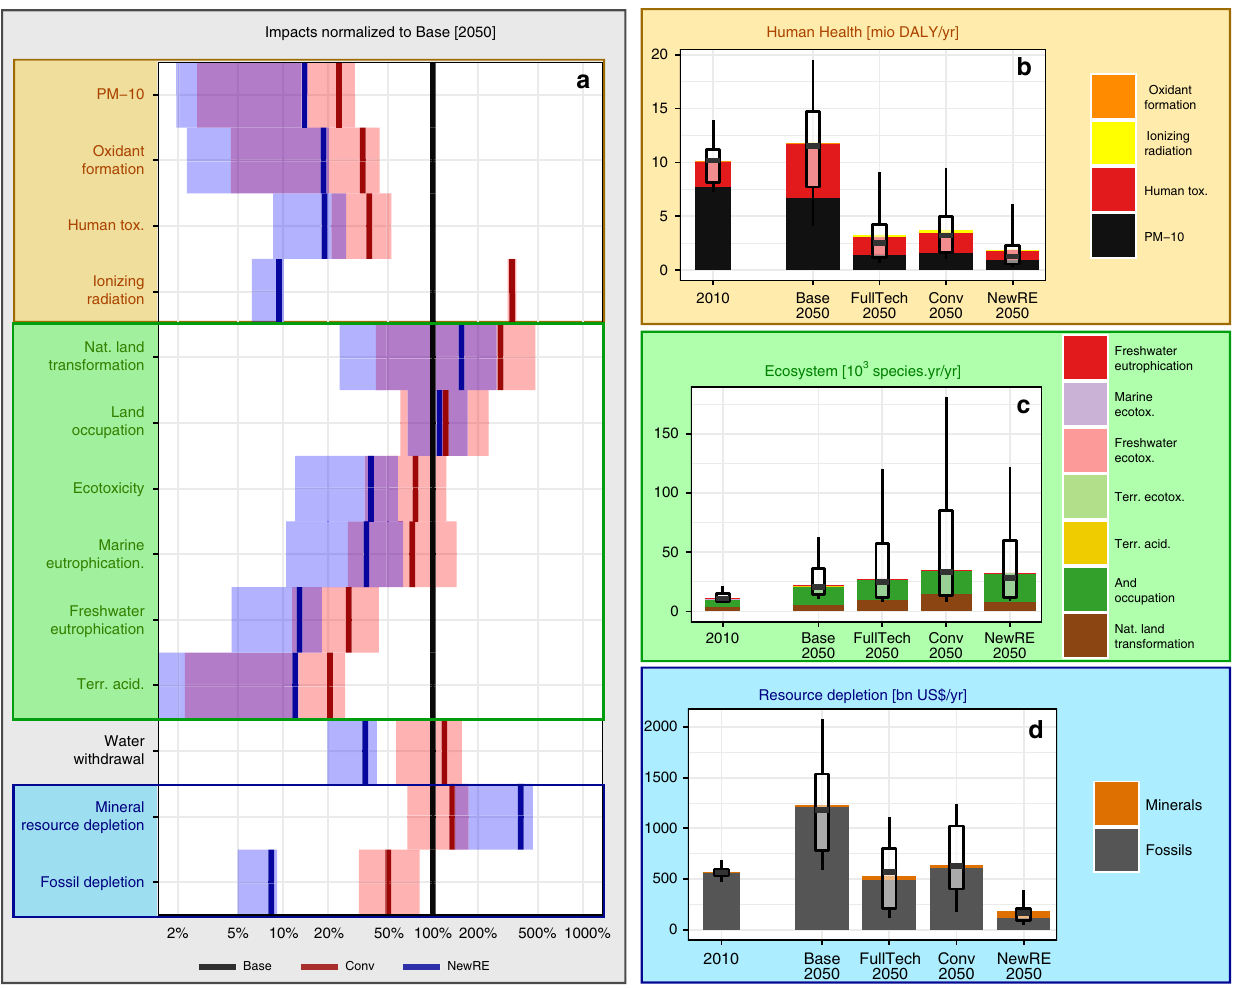
Fig. 6 Combined assessment of global environmental impacts of alternative decarbonization strategies in 2050. a Relative size of midpoint environmental impacts for conventional (Conv scenarios) vs. new renewable-based (NewRE scenarios) strategies, compared to those that would have occurred in absence of climate policies (Base scenario), on a logarithmic scale. Aggregate endpoint impacts by (midpoint) impact channel: b human health damages in disability-adjusted life-years lost, c ecosystem damage in species-years, and d surplus costs from exhaustible resource depletion. Shaded ranges in ( a ) as well as boxplots in ( b − d ) indicate interquartile ranges across IAMs and LCA technology variants, whiskers in ( a − d ) indicate 10th − 90th percentile range. Ranges do not re fl ect uncertainty in environmental impact characterization. Note that oxidant formation, freshwater eutrophication, ecotoxicity and terrestrial acidi fi cation impacts account for a below 2% share in total endpoint impacts, and are therefore barely